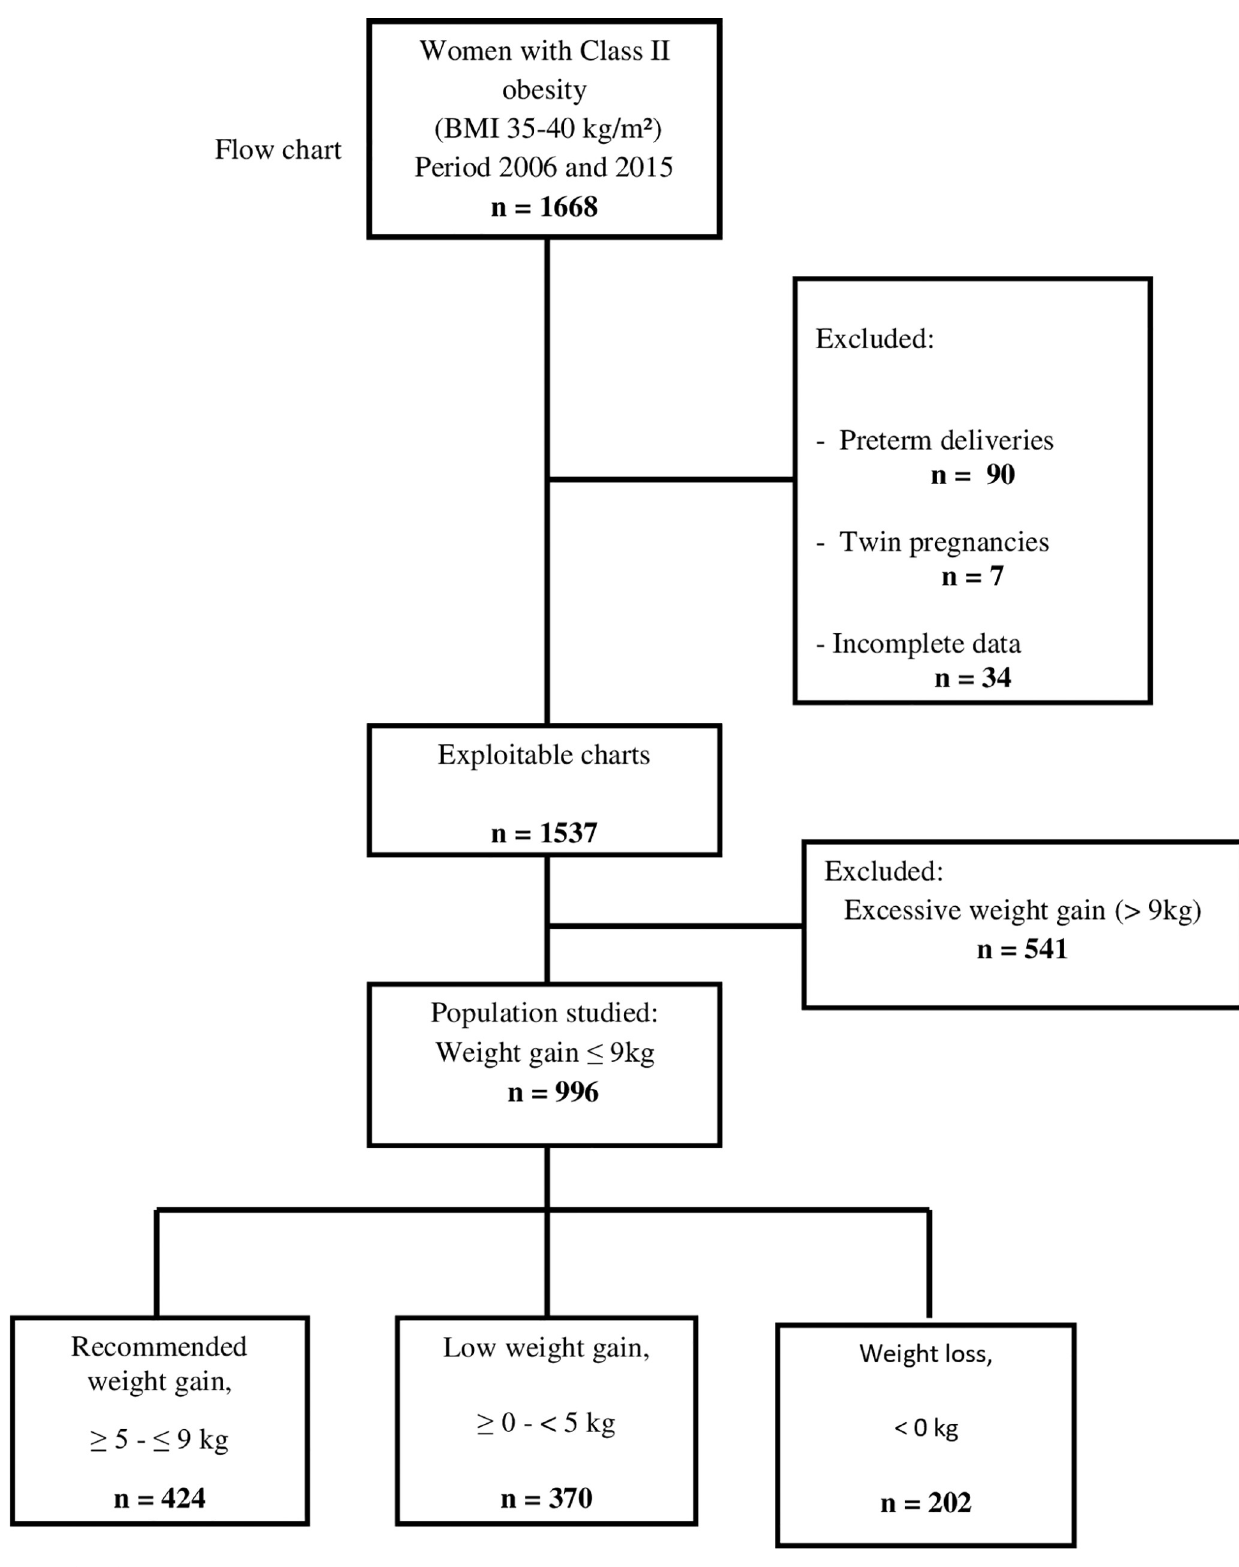
Fig 1. Flow chart.